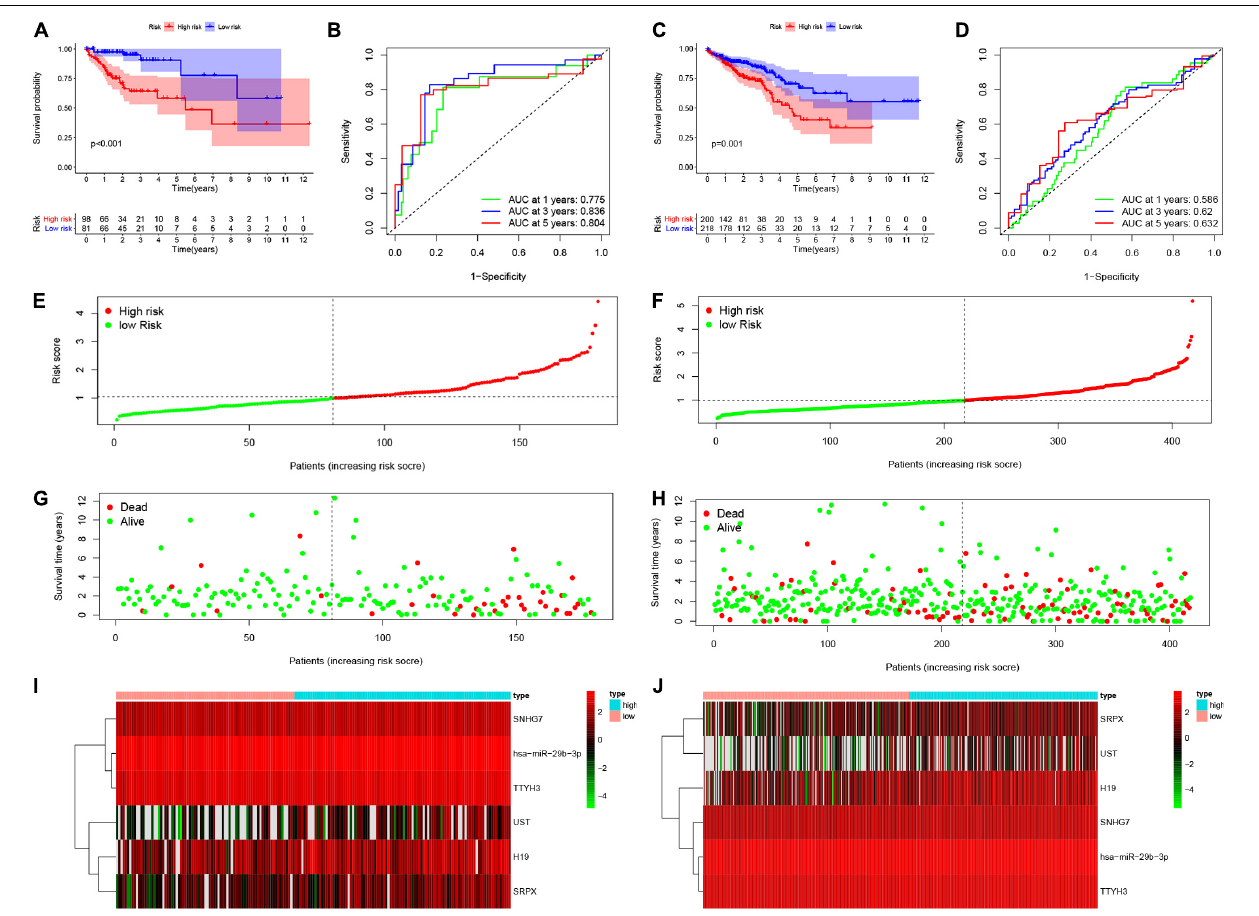
FIGURE 5 | Validation of the prognostic model. Survival probability of low-risk and high-risk patients in validation set 1 and set 1, respectively (A,C) . ROC curve was constructed to verify prognostic value of the prognostic index in validation set 1 and set 1, respectively (B,D) . Risk ranking and the survival time based on risk ranking in two sets (E–H) . Heatmap was used to identify six prognostic related gene expression between low-risk and high-risk group in validation sets (I,J)